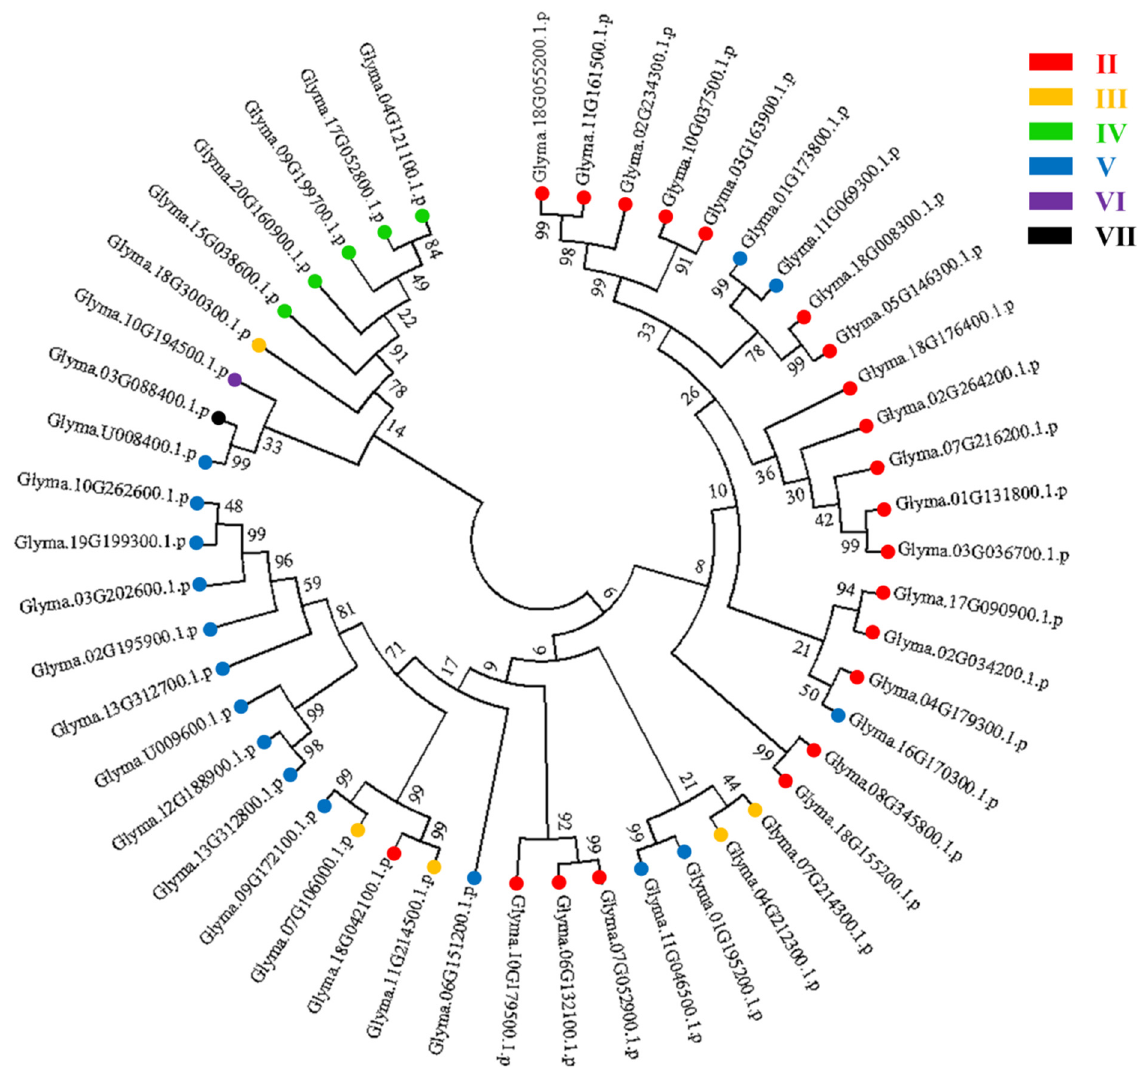
Figure 2. The phylogenetic tree of 49 GmPUB proteins. Note: the neighbor-joining (NJ) tree was constructed based on the full-length protein sequences of 49 soybean GmPUB genes .